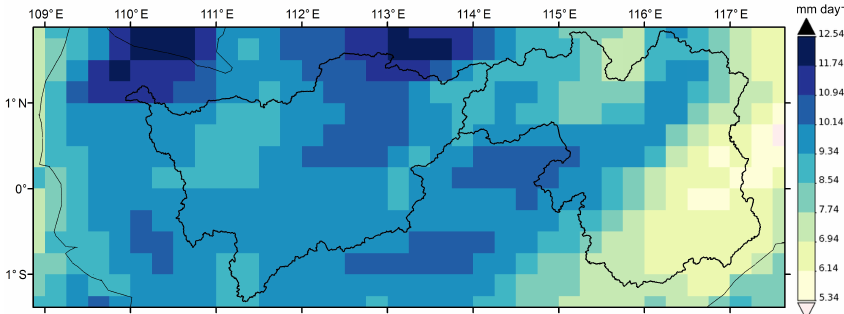
Figure 6. Spatial distribution of rainfall as TRMM daily rainfall rate (mm) averaged over January 1998–December 2014. Bold black lines indicate catchment boundaries and thin lines indicate approximate coast lines.